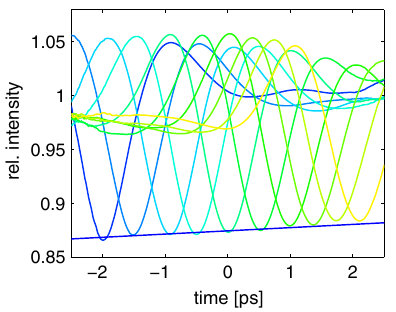
FIG. 13. Averaged EOSD measurements for ten different arrival times.